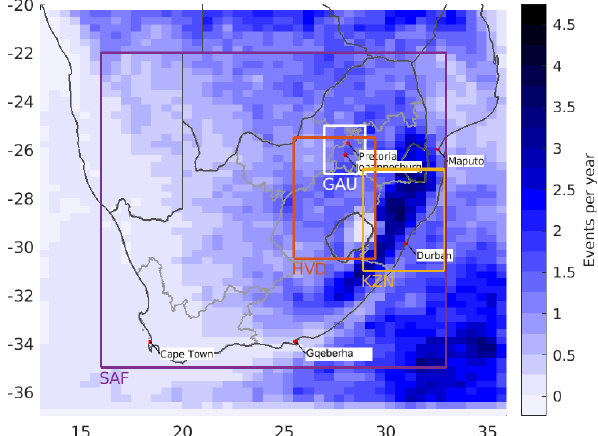
3 442 346 d. The key challenge in generating the stochastic